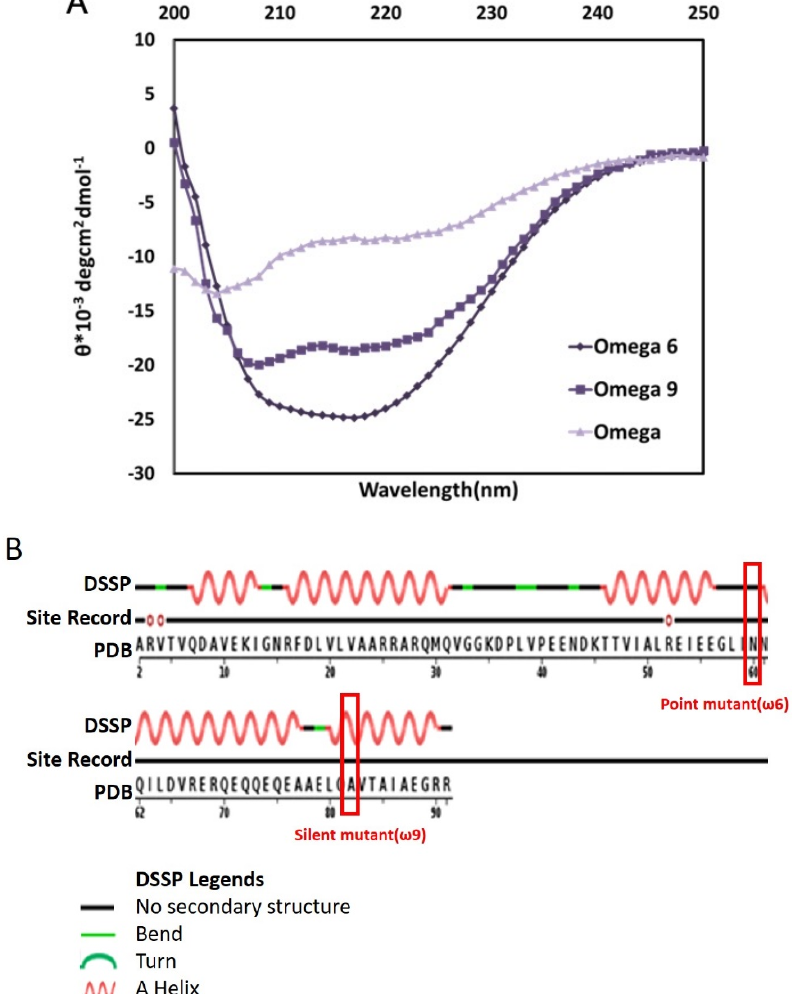
Figure 2. ( A ) Far-UV CD (Far Ultra violet Circular Dichorism) spectra for E. coli ω and its lethal mutants, ω 6, and ω 9 . CD spectra for wild-type protein shows that wild-type ω is less helical in comparison to structured mutants of ω . ( B ). The structure of ω -subunit in RNAP assembly. The ω -subunit exists as a well folded structure in the RNAP assembly in the crystal structure PDB id: 4JKR [35], of E. coli RNA polymerase.